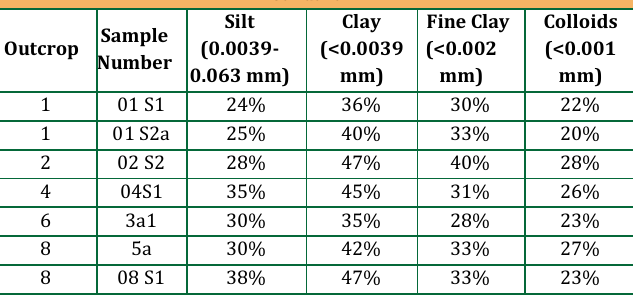
Table 2: Percentage content of fine-grained particles in mudstones